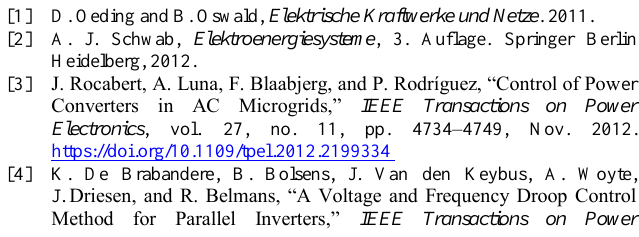
Fig. 13. a.) BSS and genset power curve for 1 day. b.) Resulting SOE curve (scenario 4). R